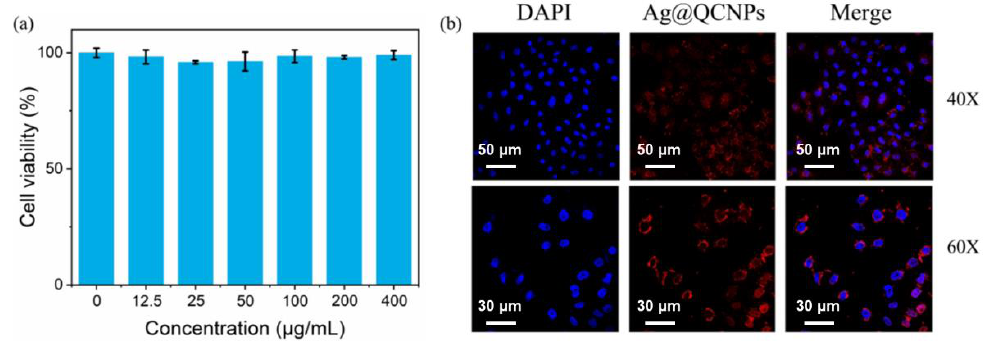
Figure 5. In vitro experiments with Ag@QCNPs. ( a ) Effect of Ag@QCNPs on survival of HT-29 cells; ( b ) CLSM images of HeLa cells incubated with Ag@QCNPs and DAPI at different magnifications.